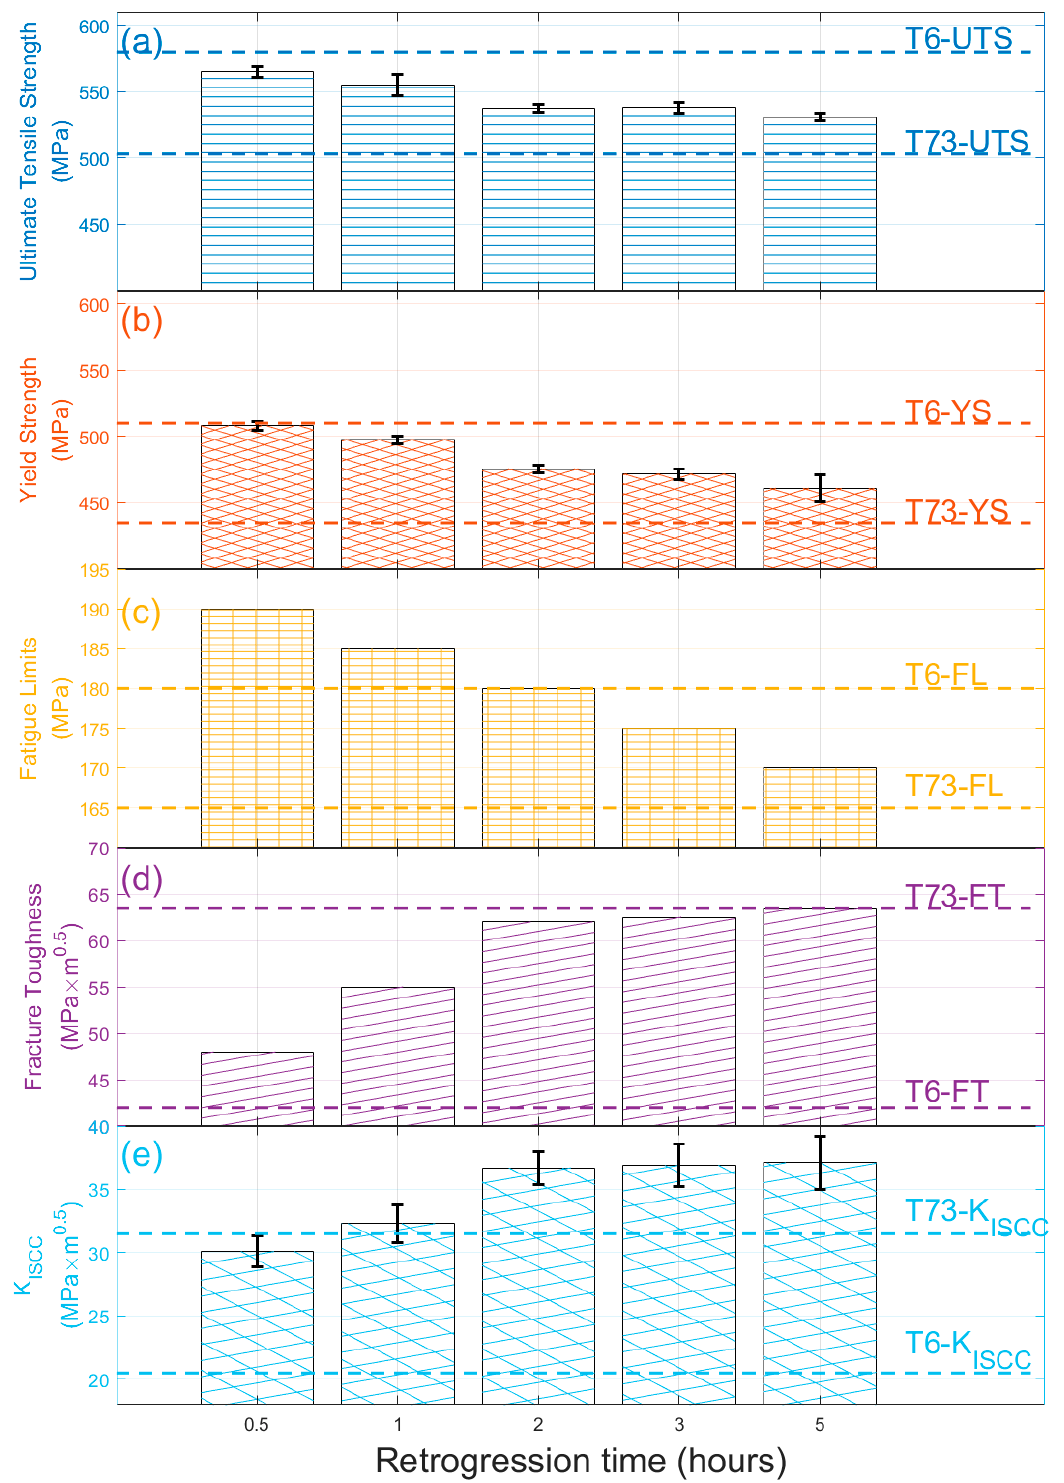
Figure 1. Effects of retrogression time at 180 ◦ C on ( a ) ultimate tensile strength (UTS, MPa), ( b ) Yield strength (YS, MPa), ( c ) Fatigue endurance limits (FL, MPa), ( d ) Fracture toughness (FT, MPa √ m), and ( e ) K ISCC (MPa √ m). Symbols “T6” and “T73” in the fi gure represented the benchmark of these conventional treatments.